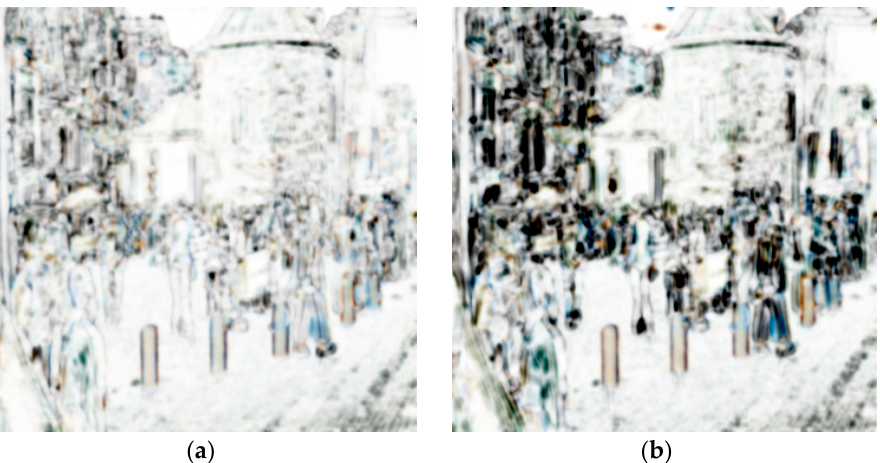
Figure 2. Similarity maps of ( a ) the content loss function and ( b ) the style loss function.